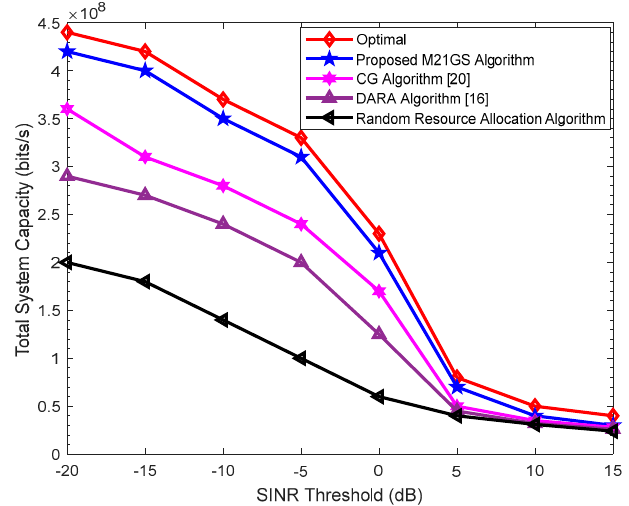
Figure 5. Impact of SINR threshold on total system capacity.